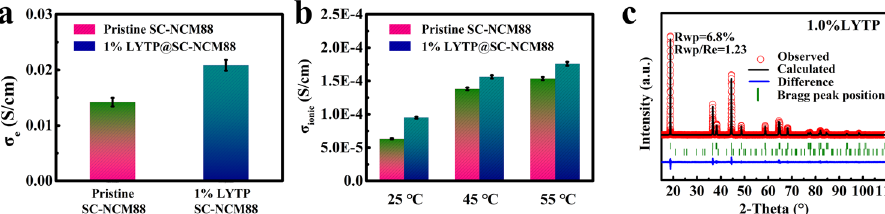
Fig. 3 Conductivity measurements and structural characterization of LYTP@SC-NCM88. The comparison of ( a ) electron conductivity and ( b ) Li-ion conductivity between pristine SC-NCM88 and 1% LYTP@SC-NCM88. Error bars represent the standard deviations of three measurements for conductivity. c The XRD Rietveld re fi nement of 1%